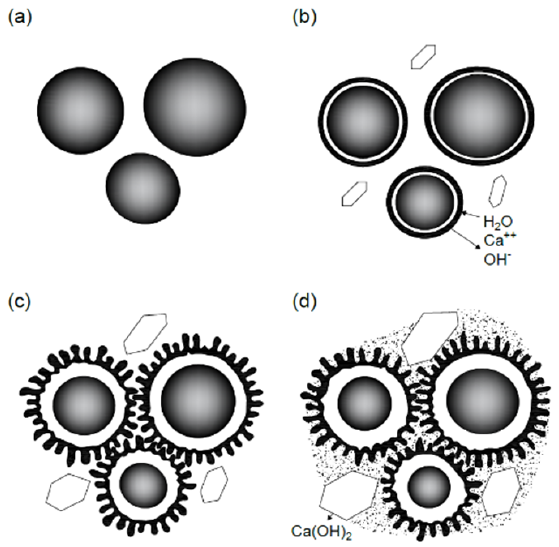
Figure 1. Scheme of the process of transformations in the structure of cement paste and hardened cement paste during cement hydration: ( a ) cement grains in water—the initial period of hydration; ( b ) formation of a gel shell on cement grains—a latent period of hydration; ( c ) secondary growth of the gel shell after the osmotic destruction of the original shell, the formation of wavy and columnar structures on the surface of the grains and in the pores of the hardened cement paste—the third period of hydration; ( d ) compaction of the structure of the hardened cement paste during subsequent hydration of the cement.